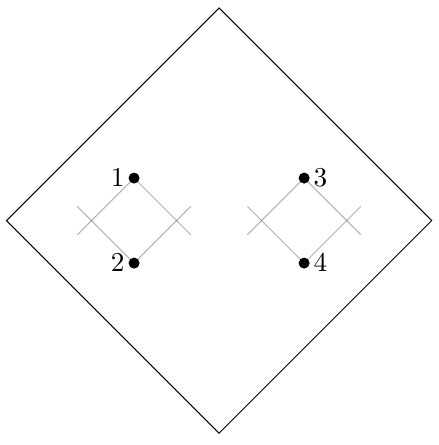
Figure 16. A con(cid:12)guration of points where 1 > 2 and 3 > 4, with all other pairs of points spacelike-separated. The three-point structure (H.13) is positive in this